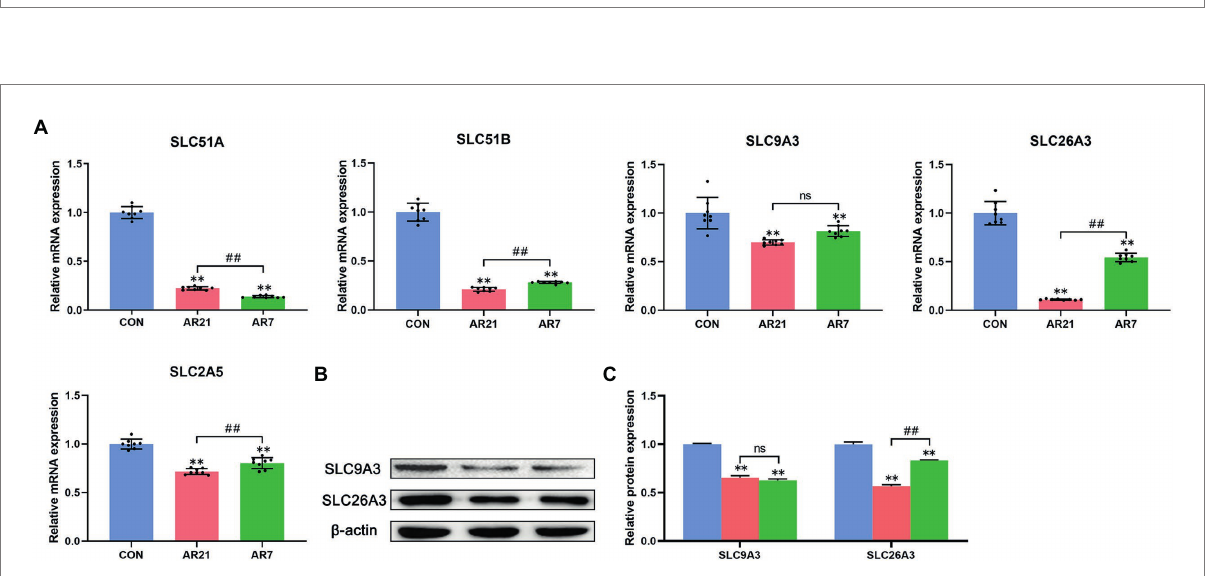
FIGURE 9 Effects of artificial rearing on SLC family members in piglet colon. (A) Relative mRNA expression of SLC51A, SLC51B, SLC9A3, SLC26A3, and SLC2A5. (B,C) Relative protein expression of SLC9A3 and SLC26A3. Data are presented with mean ± SD. ns p > 0.05; ** p < 0.01 versus the CON group; # p < 0.05 versus the AR21 group; ## p < 0.01 versus the AR21 group. n = 8